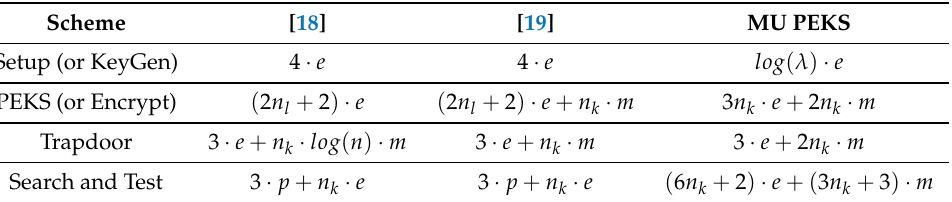
Table 5. The comparison without complex access control.